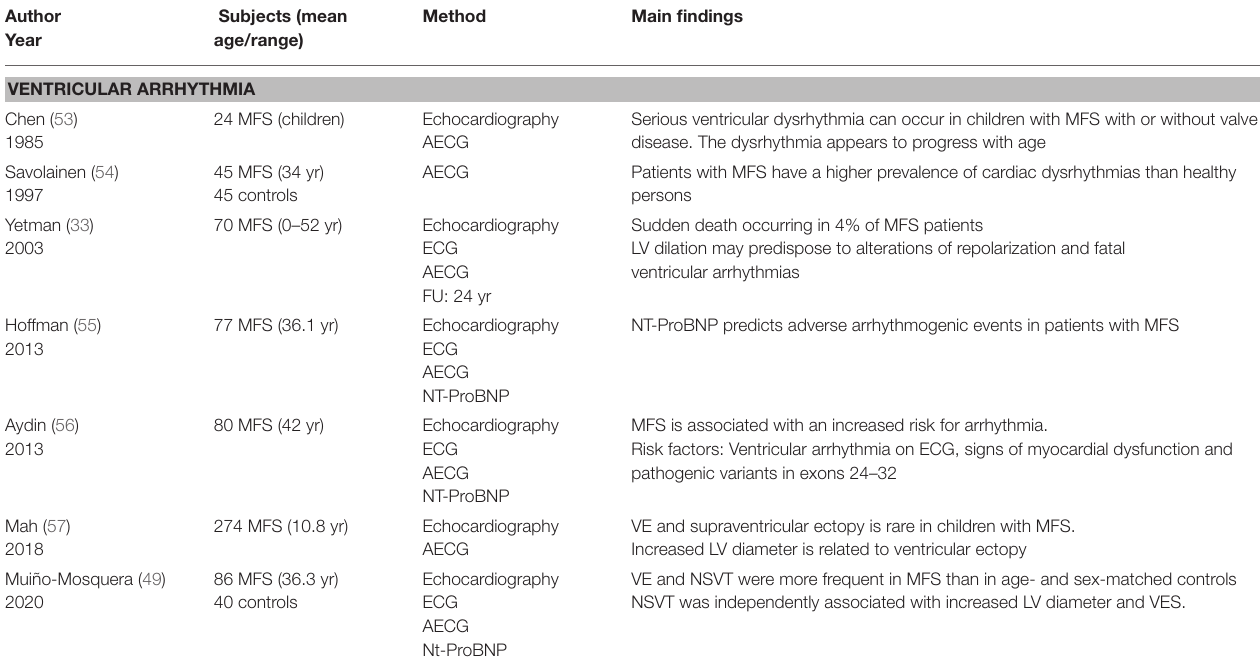
TABLE 3 | Overview of the published papers evaluating ventricular arrhythmia in